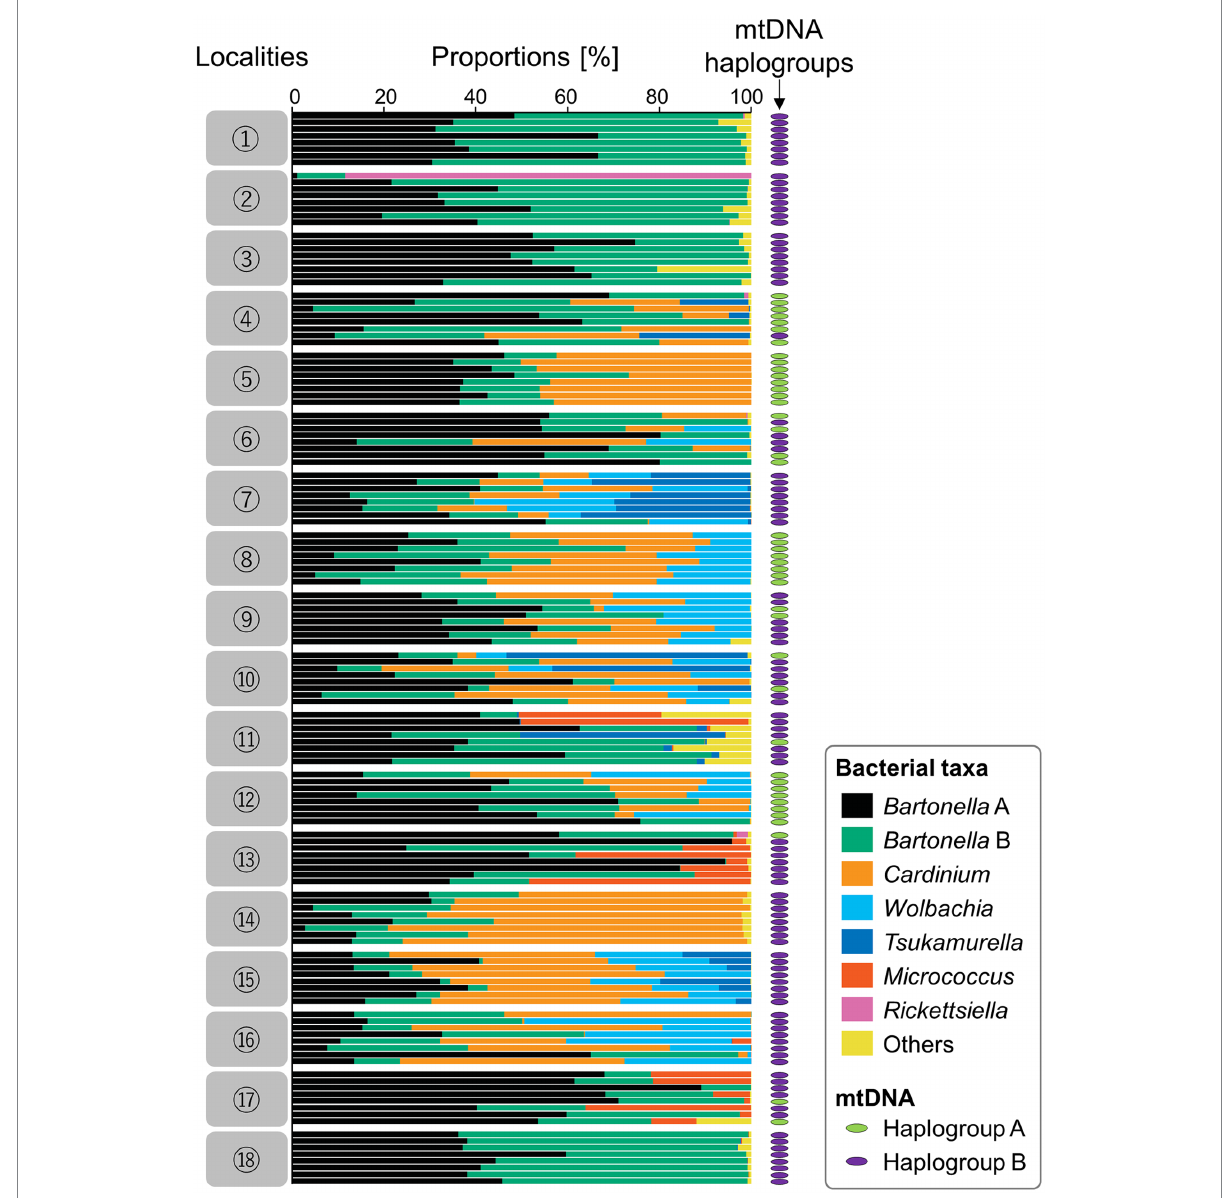
FIGURE 3 Results of amplicon sequencing of the hypervariable V3/V4 region using 144 individual D. gallinae mites from 18 poultry farms (eight individual mites from each poultry farm). For each individual, an mtDNA haplogroup (either A or B) is shown by a colored ellipse at the right (green for haplogroup A; purple for haplogroup B). Assigned bacterial taxa are color-coded as shown in the box on the right. Numbers on the left represent geographic localities shown in Figure